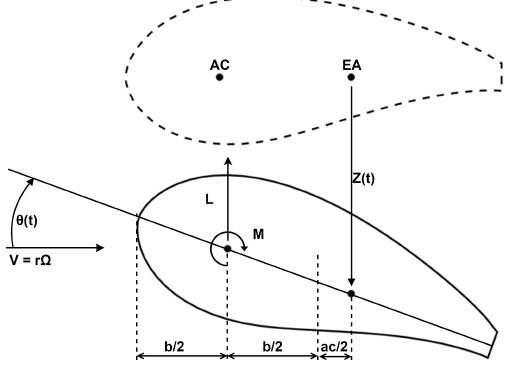
Figure 1. Illustration of a two-dimensional airfoil undergoing heave and pitch